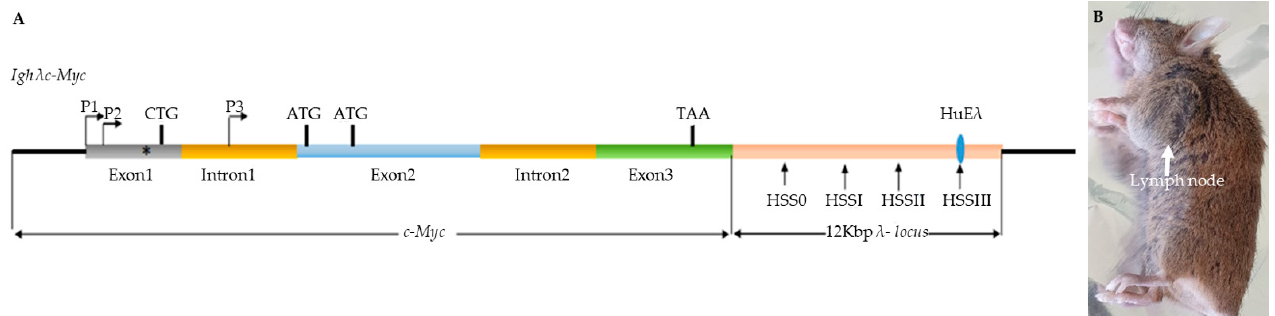
Figure 1. ( A ) Structure of the λ c-MYC transgene; ( B ) carried by the λ c-MYC ( A vy /a ) model mouse of Burkitt’s lymphoma. Horizontal arrows indicate the two c-MYC promoters, P1 and P2, located in the first noncoding exon. Vertical arrows indicate the locations of the four previously defined [14] DNaseI-hypersensitive sites (HSS) in the IglL; CTG, ATG, and ATG shown represent the previously described translation initiation sites for c-Myc1, c-Myc2, and c-MyS, respectively. Diagram is not to scale. *: PvuII